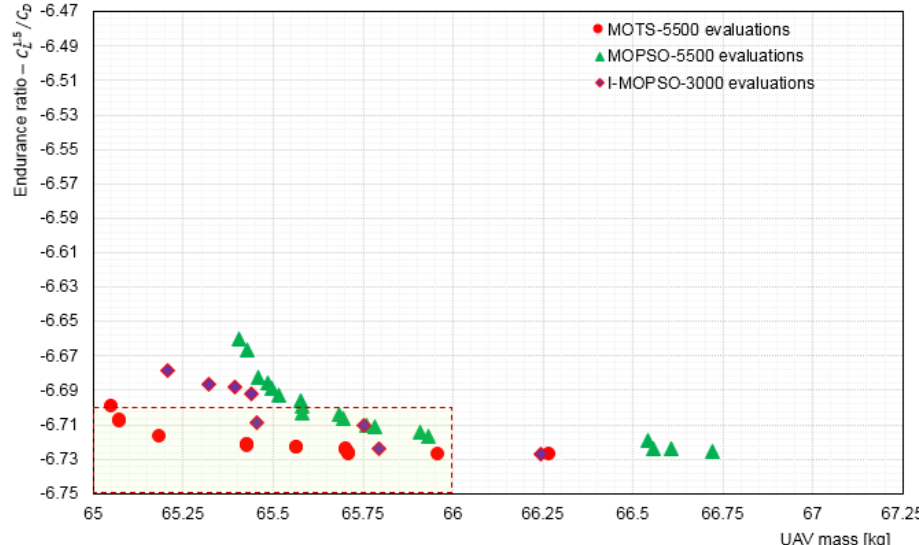
Figure 15. Comparison of Pareto front for MOTS and MOPSO using 5500 evaluations, and with I-MOPSO using 3000 evaluations.